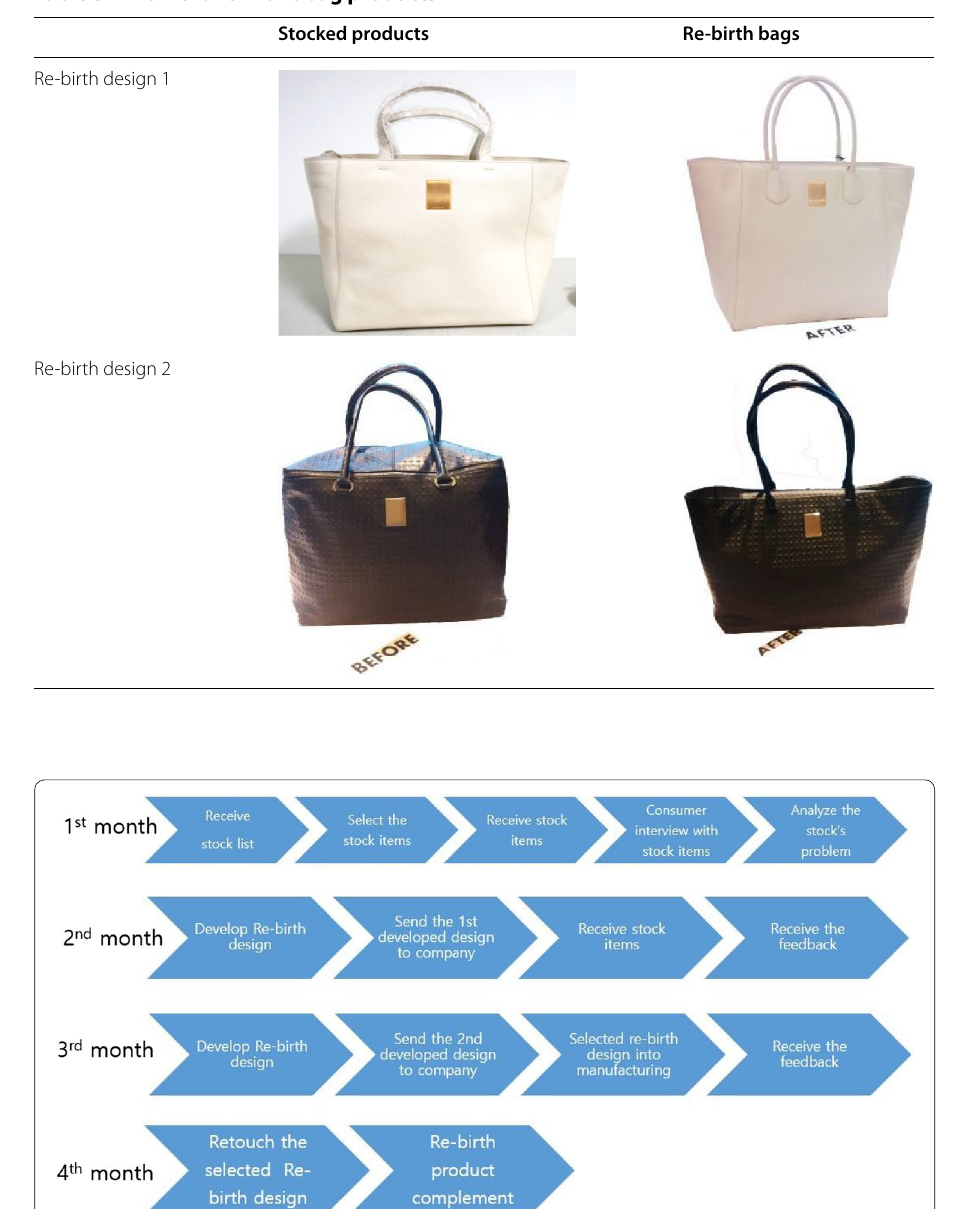
Table 3 Final re-birth handbag products